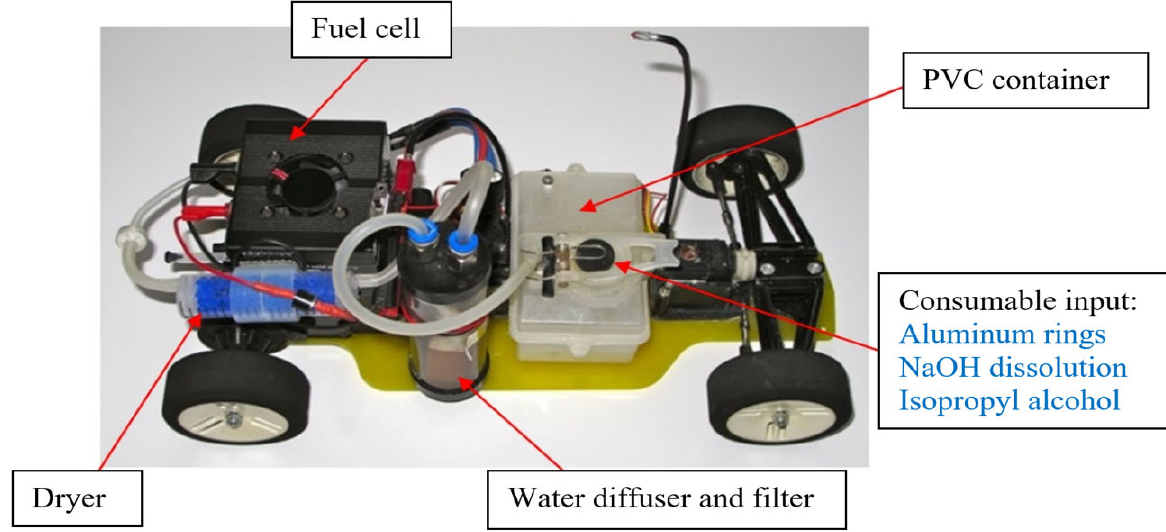
Figure 2. Hydrogen generation, filtering, and drying areas for the fuel cell of an RC car. (Photography: Aleix Llobet).